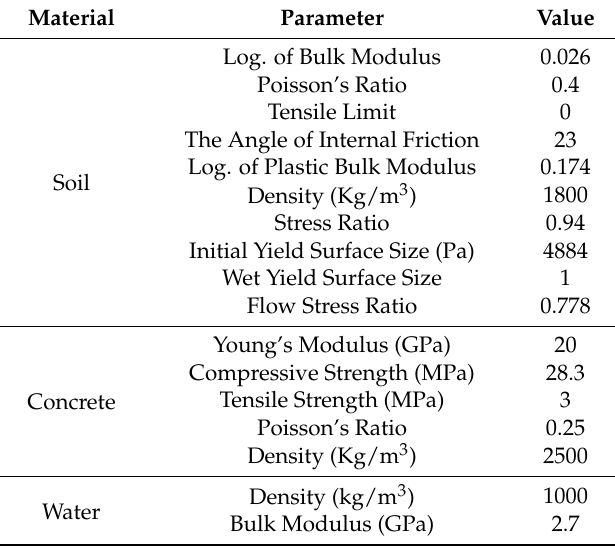
Table 1. Properties of the materials used in the model [21,22]